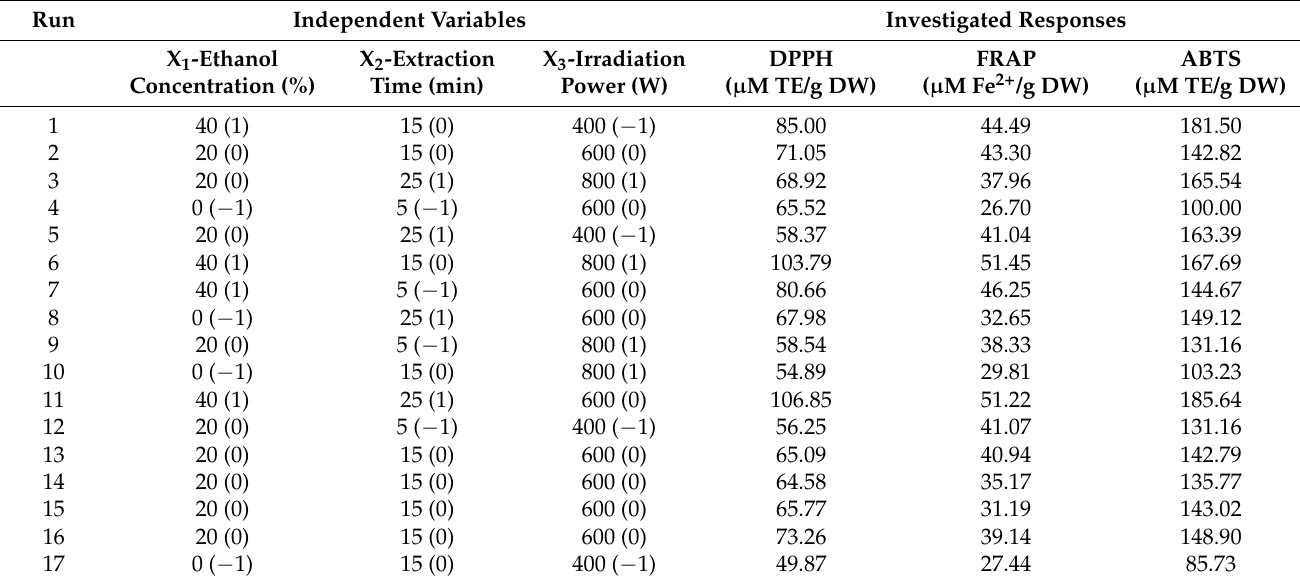
Table 1. Box–Behnken experimental design with natural and coded MAE conditions and experimen- tally obtained values of antioxidative activity (DPPH, FRAP and